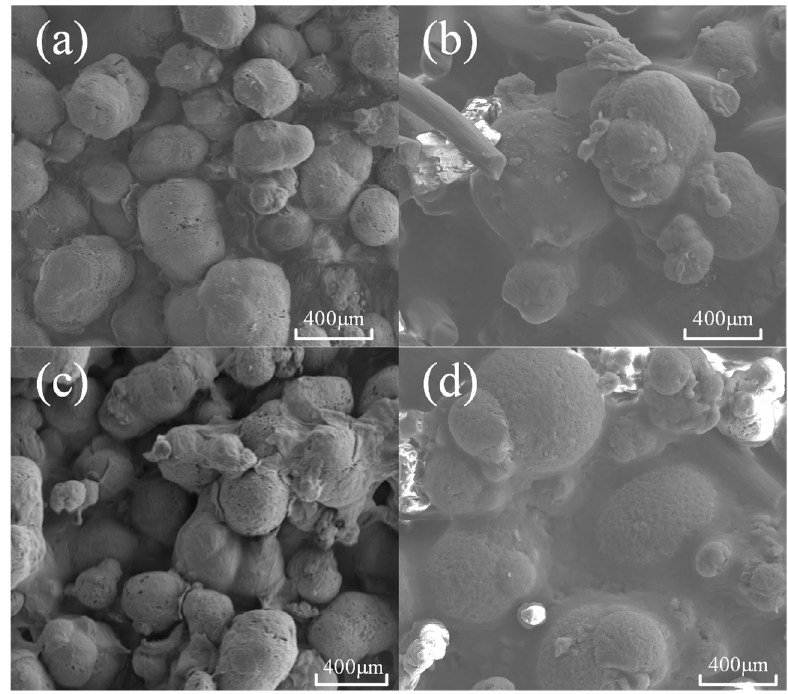
Figure 4. Surface morphology of CF/PA12 and PA12 before and after immersion: ( a ) 0 h-PA12; ( b ) 0 h-CF/PA12; ( c ) 72 h-PA12; and ( d ) 72 h-CF/PA12.